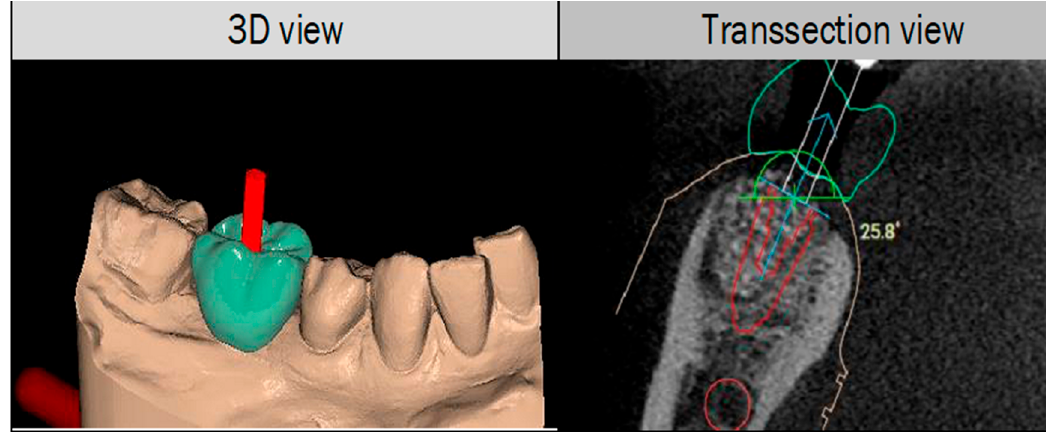
Figure 2. The location of the IAN, the safety zone and planned implant position guided by the virtually designed restora- tion using Megagen R2 Gate.